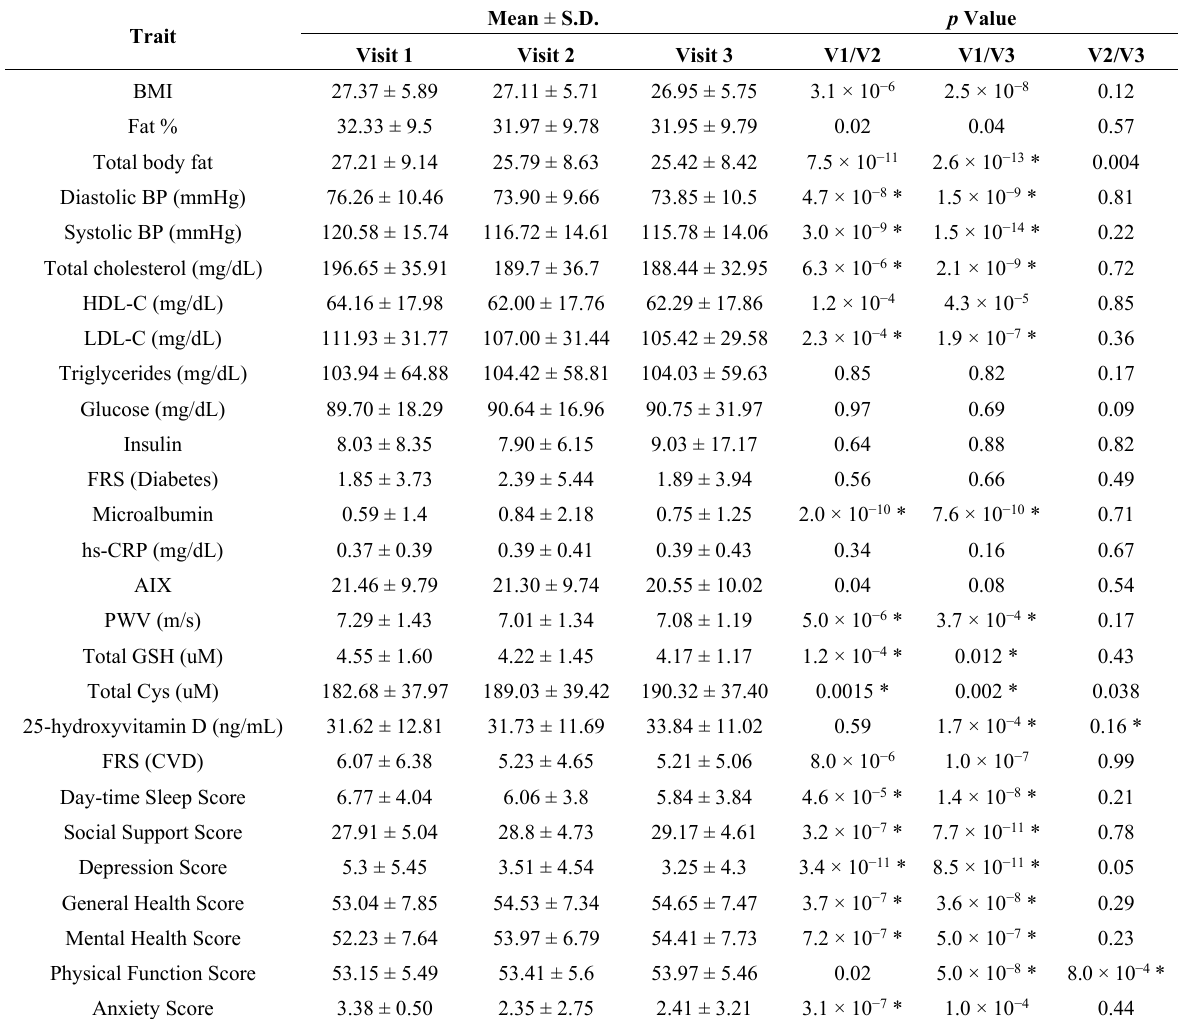
Data for 382 participants who completed at least three visits are presented. p Values obtained from paired Wilcoxon test performed on Z-scores of log transformed values. * p Value <0.05 for unpaired Wilcoxon